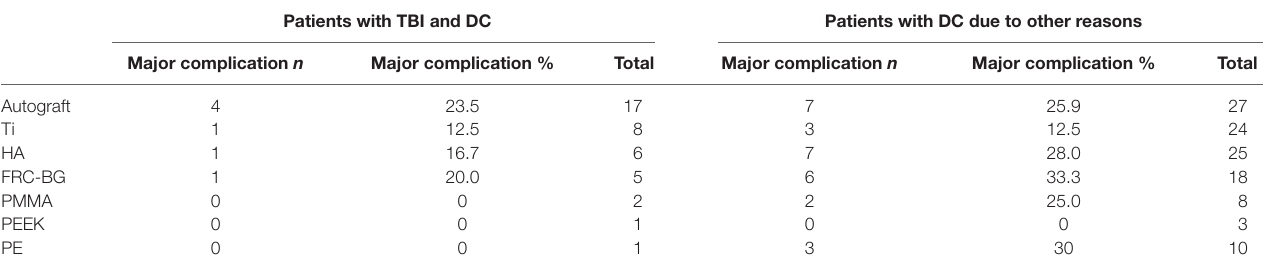
TaBle 2 | Cranioplasty materials and major complications leading to implant removal.